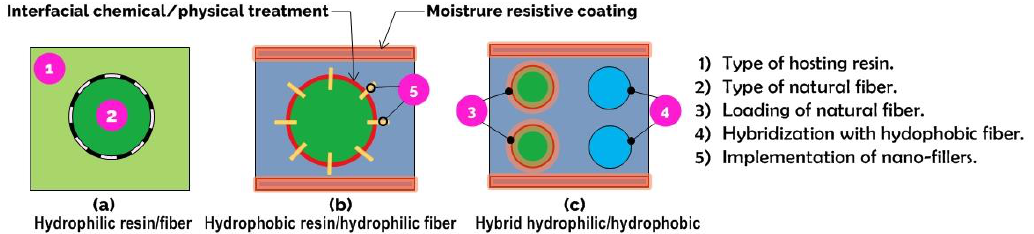
Figure 2. Main parameters affecting the efficiency of chemical/physical treatments.